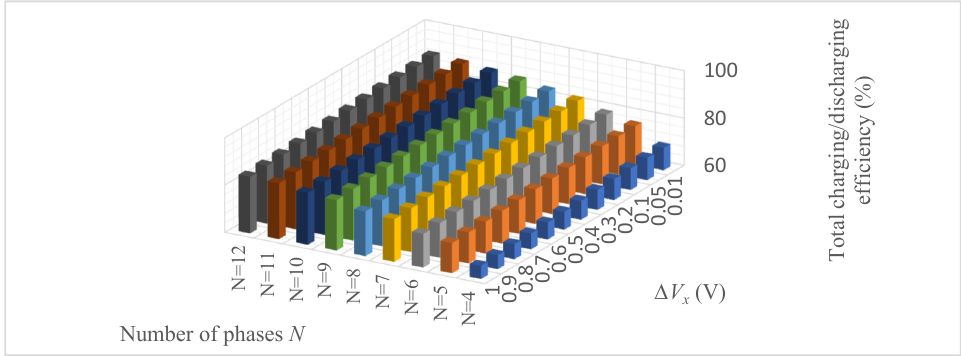
Figure 22. Charging efficiency of SC circuit at different ∆ V x for different numbers of phases.